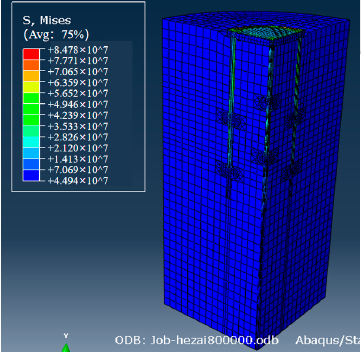
Figure 15. Stress cloud of 800 kPa load.